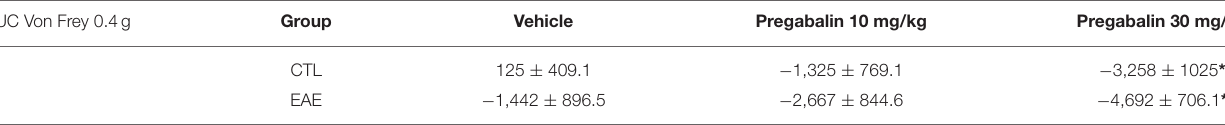
TABLE 4 | Summary table of pharmacological effect of pregabalin on mechanical and thermal sensitivity in mice immunized with MOG 35 − 55 (QuilA-EAE) and their controls (CTL) during the chronic phase of the disease. AUC Von Frey